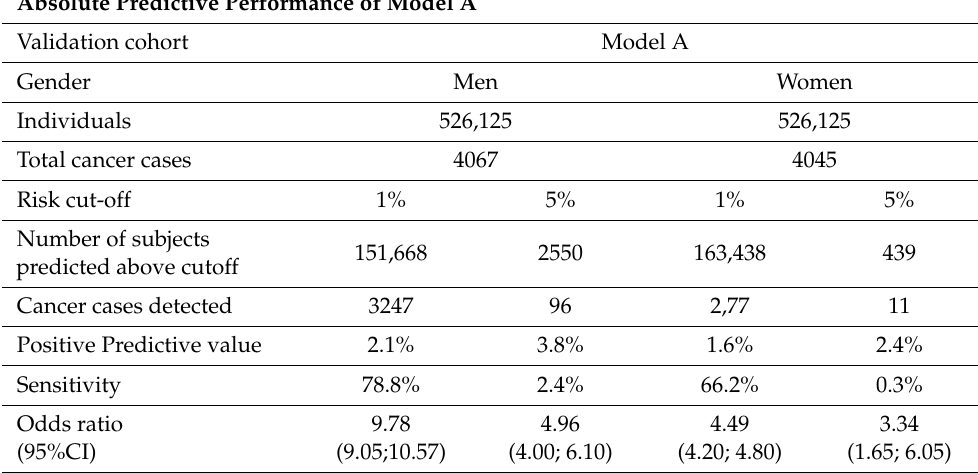
Table 5. Absolute predictive performance of Model